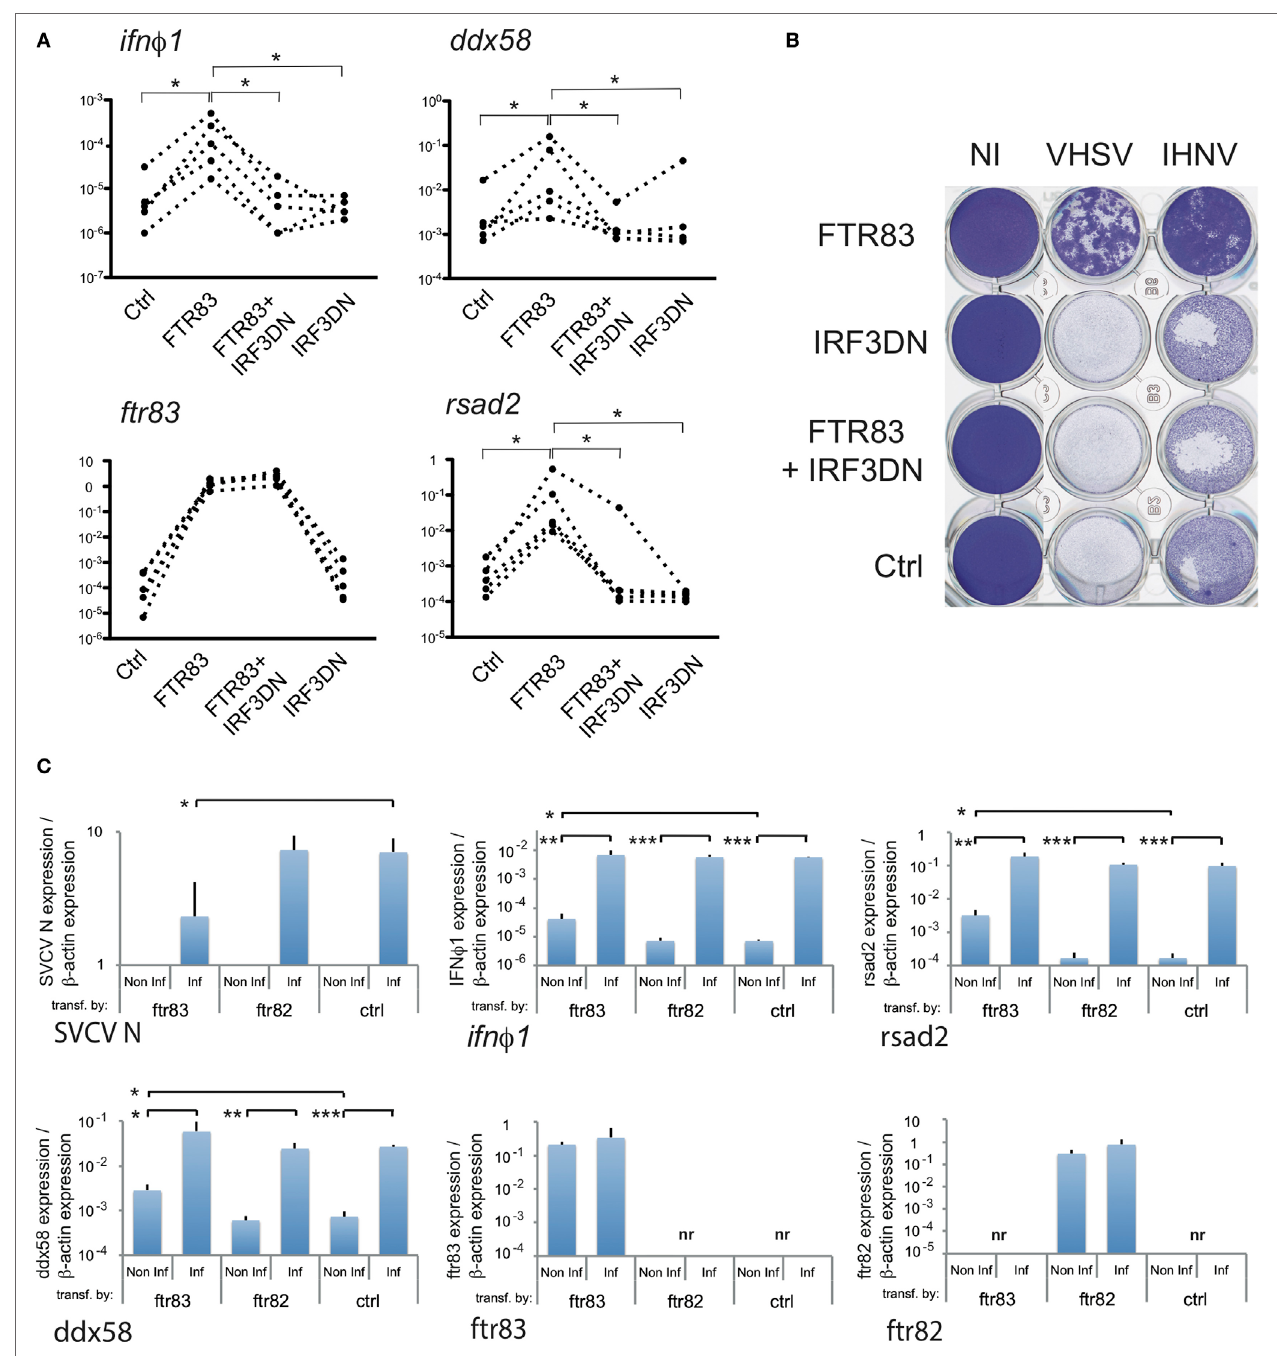
FigUre 5 | FTr83-mediated protection against rna viruses relies on induction of type i interferon . (a) Epithelioma papulosum cyprini cells were transfected with expression plasmid for ftr83 , irf3DN or co-transfected ( ftr83 + irf3DN ). Cells transfected with empty plasmid were used as control (Ctrl). Transcripts of interest were quantified by RTQPCR. Five representative experiments are represented, and correspond to dotted lines (* p < 5%, Wilcoxon signed-rank test). (B) Transfected cells were infected by IHNV or VHSV (MOI 1) at 72 hpt, and viral-induced cytopathic effect was assessed by crystal violet staining at 72 hpi. Mock-transfected cells (Ctrl) and non-infected cells (NI) were used as controls. (c) Transfected cells were infected at 72 h post transfection with spring viremia of carp virus (SVCV) (MOI 1), and transcripts of interest were quantified by RTQPCR 6 h postinfection. Results of RTQPCR were normalized on the β -actin expression: measured ratio of cDNA of interest/ β -actin cDNA is shown. Mean and SD are shown, for three independent experiments, and the average of induction or repression fold between infected and non-infected cells is shown when relevant. Stars indicate significant differences using Student’s t -test (*** p < 0.001, ** p < 0.01, * p <